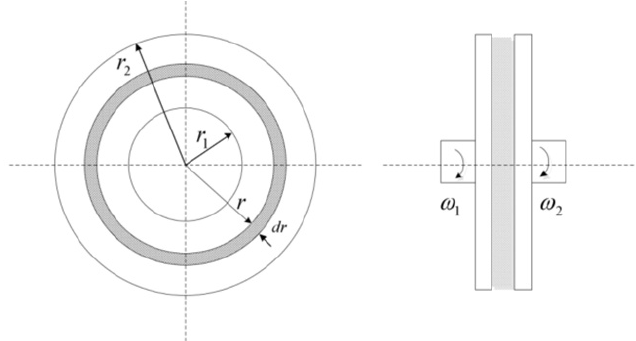
Figure 2. Simplified model of friction pair.